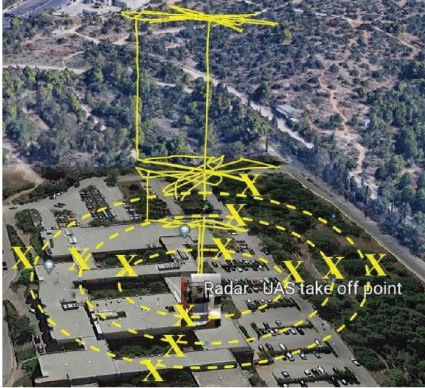
Figure 9: Flight path for the 360 ° scanning mode, with the UAS hovering in fxed